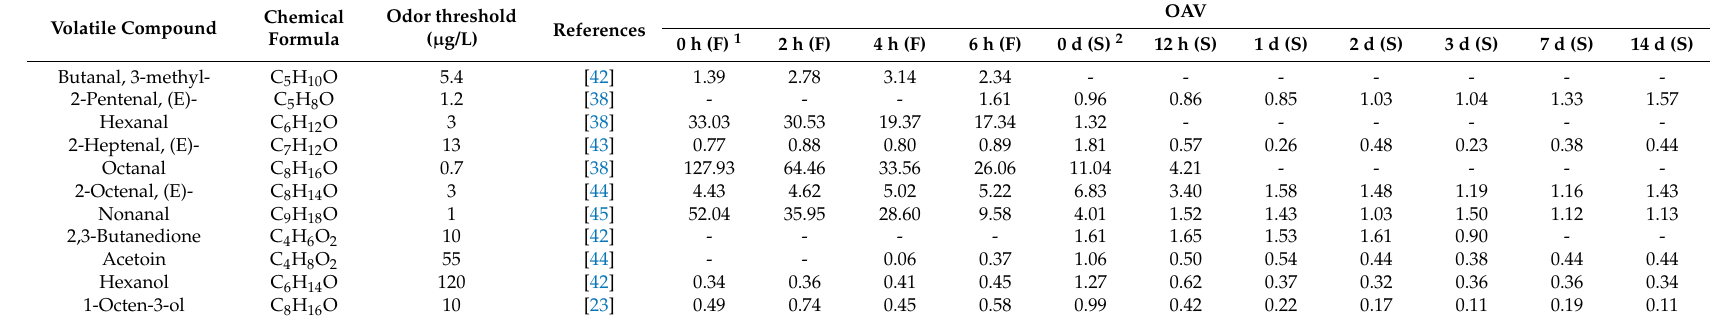
Table 2. Odor activity values (OAVs) for compounds produced in milk fermented by S. thermophilus MGA45-4 during fermentation and